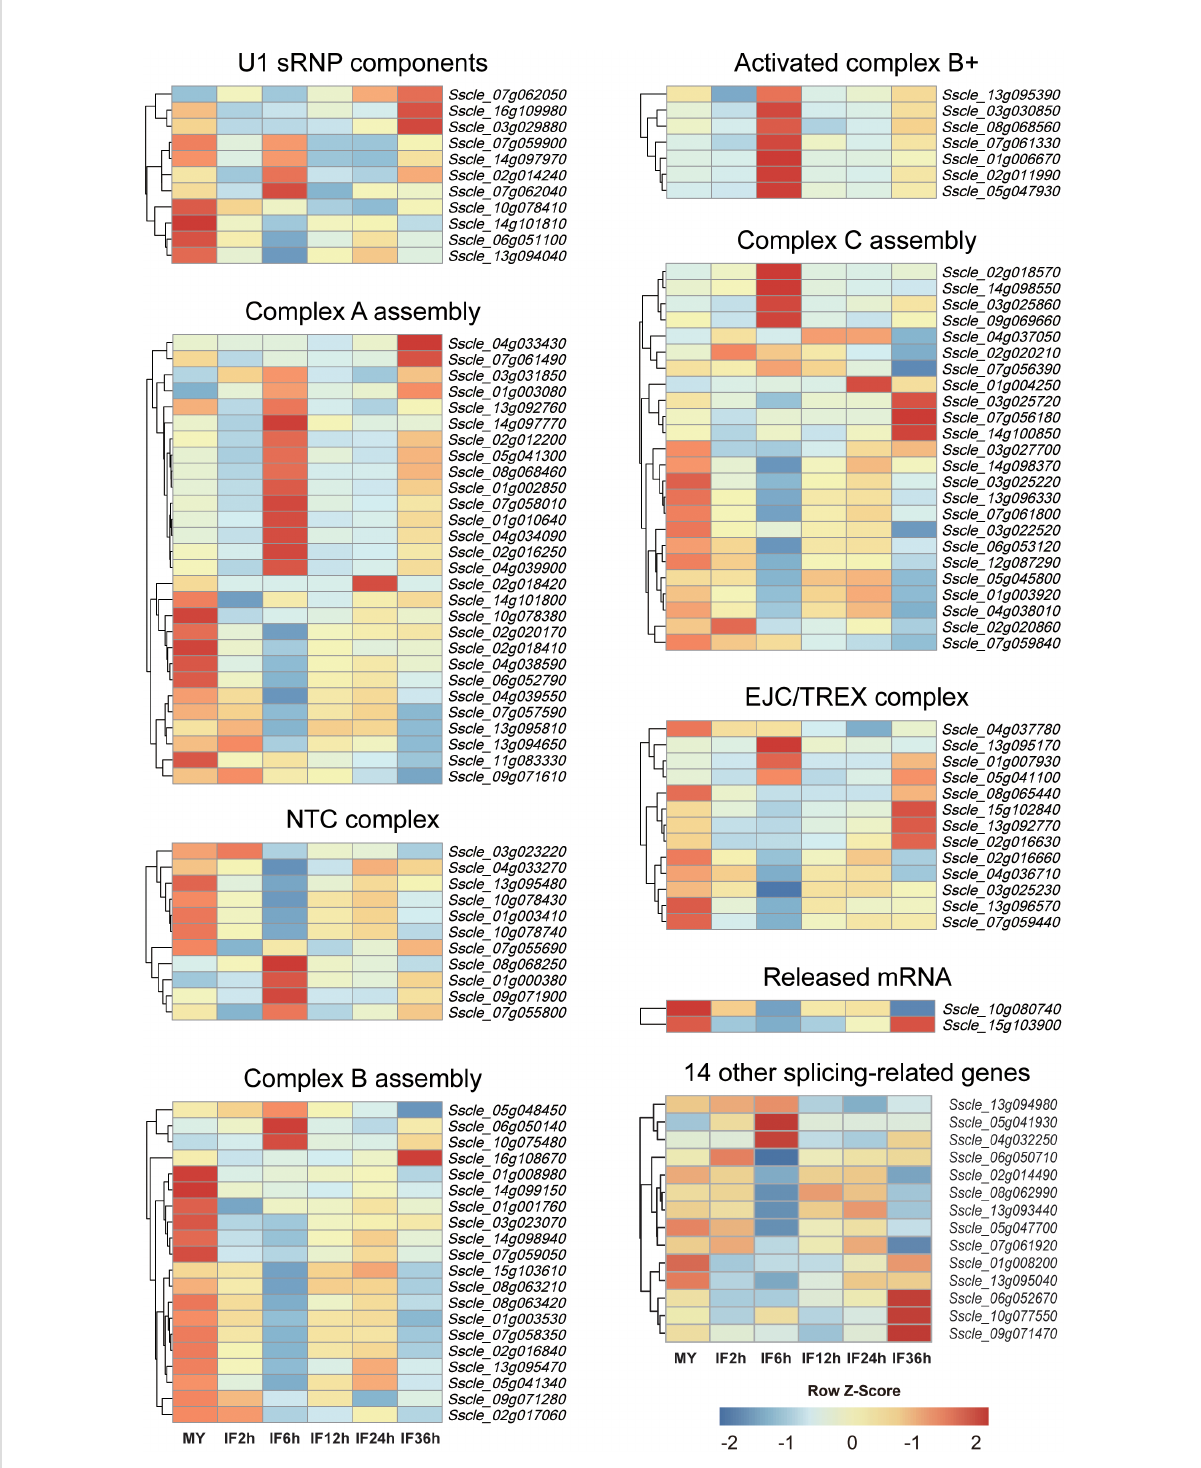
FIGURE 2 Expression patterns of splicing ‐ related genes during S. sclerotiorum infection on Brassica napus . The gene ID of splicing factors is listed in the heat map. Blue to red indicate gene expression values from low to high. Z score normalization was applied for the transcription levels of genes at all stages. Cluster analysis was performed using the R package